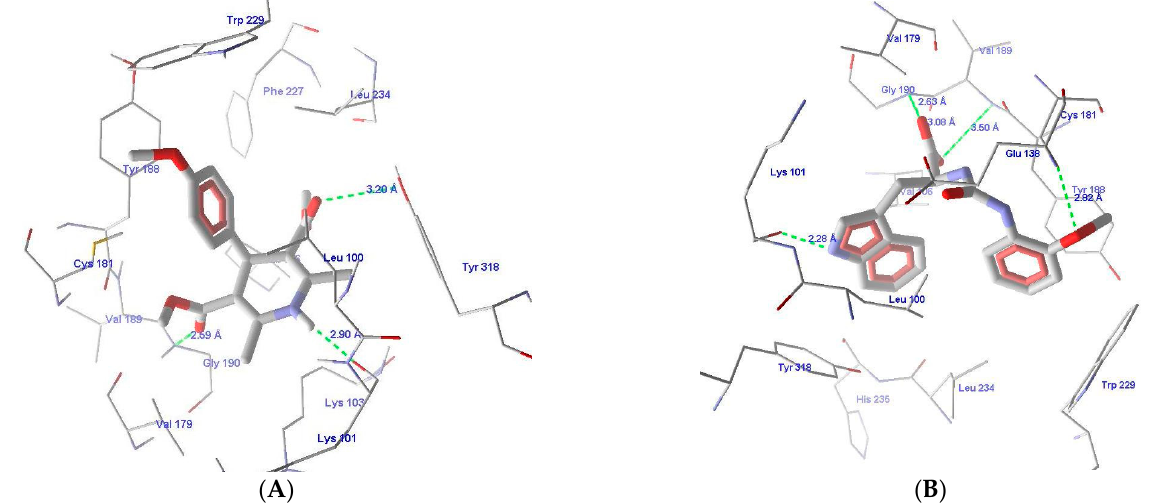
Figure 9. The comparative docking of screened ligands ( A ) ZINC19286543 and ( B ) ZINC02146330 showed butterfly conformation and important hydrophobic interactions, along with hydrogen-bond interactions with Lys101 and other important residues in the NNRTI’s binding site.